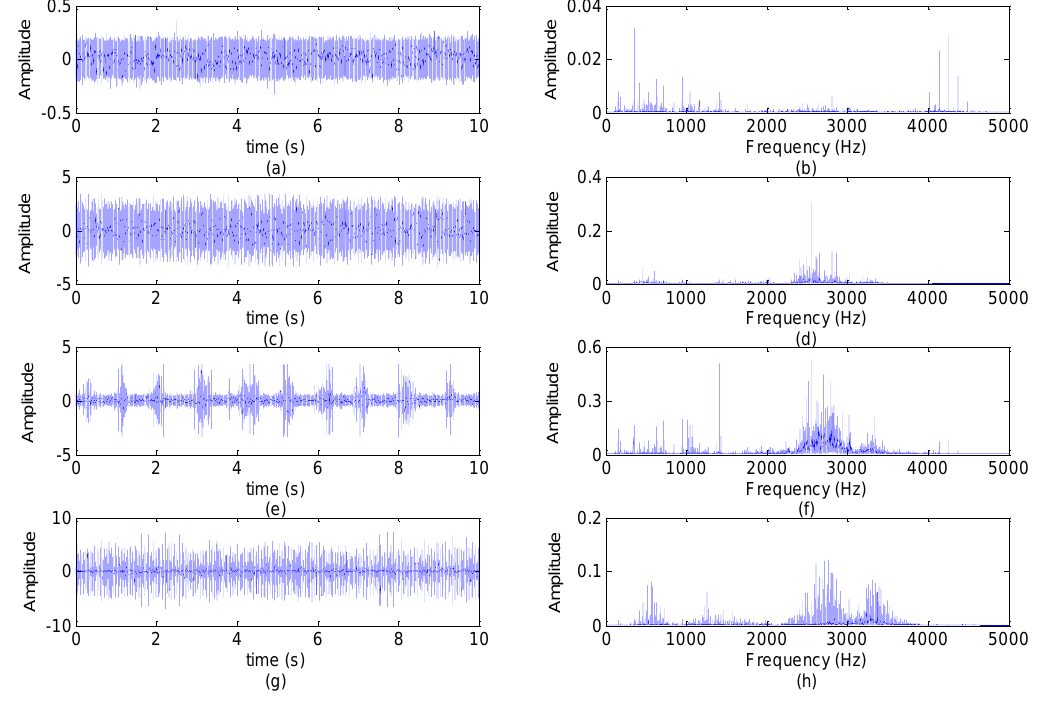
Figure 4. The vibration signal waveforms and power spectra from the different fault types: ( a , b ) Normal bearing vibration waveform/power spectrum; ( c , d ) Inner race fault vibration waveform/power spectrum; ( e , f ) Ball fault vibration waveform/power spectrum; ( g , h ) Outer race fault vibration waveform/power